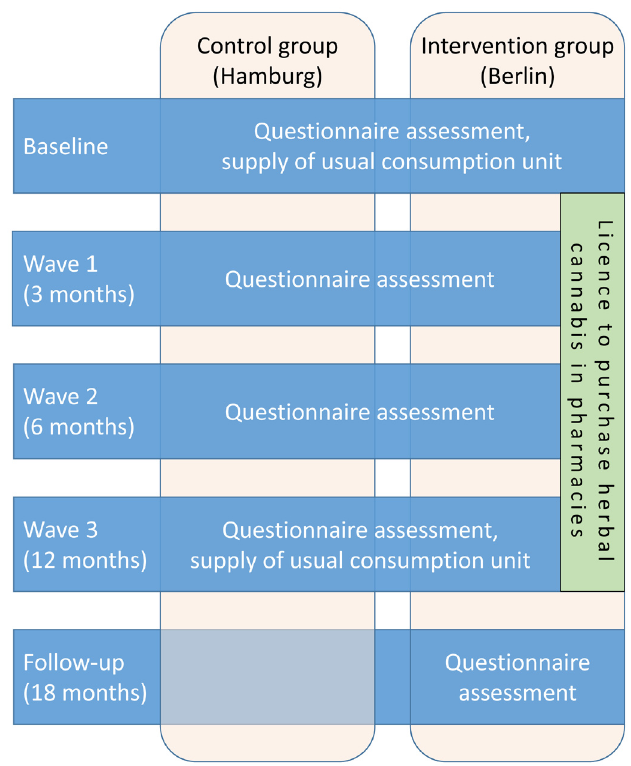
Figure 1. Study flow